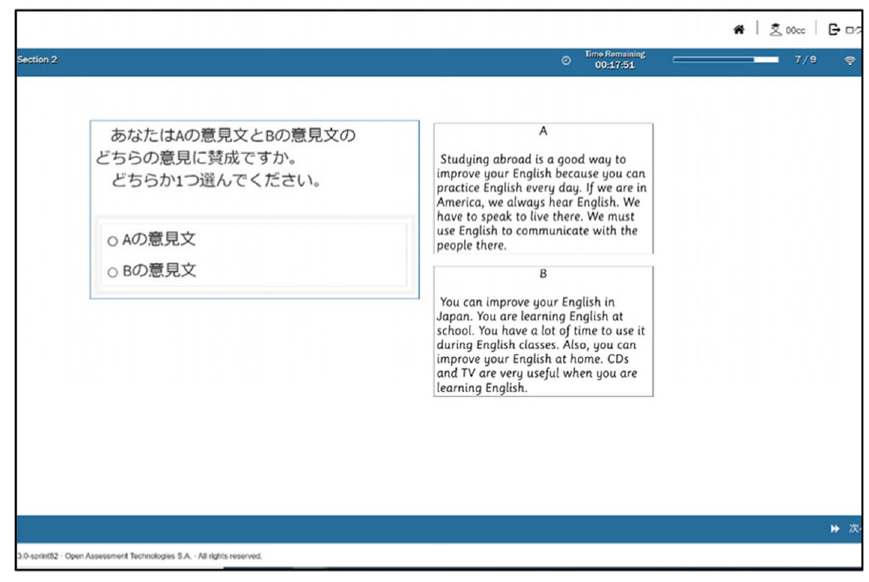
Fig. 4 Screen 3: Choose the outline of the source texts